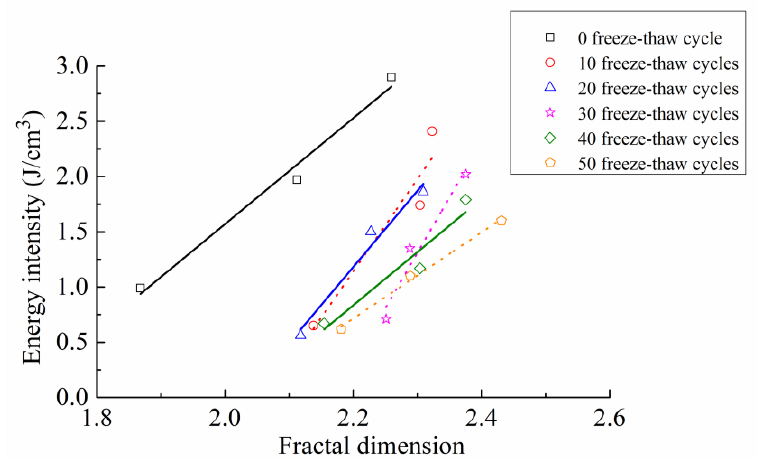
Figure 14. Relation fitting curves of the energy consumption density and the fractal dimension.